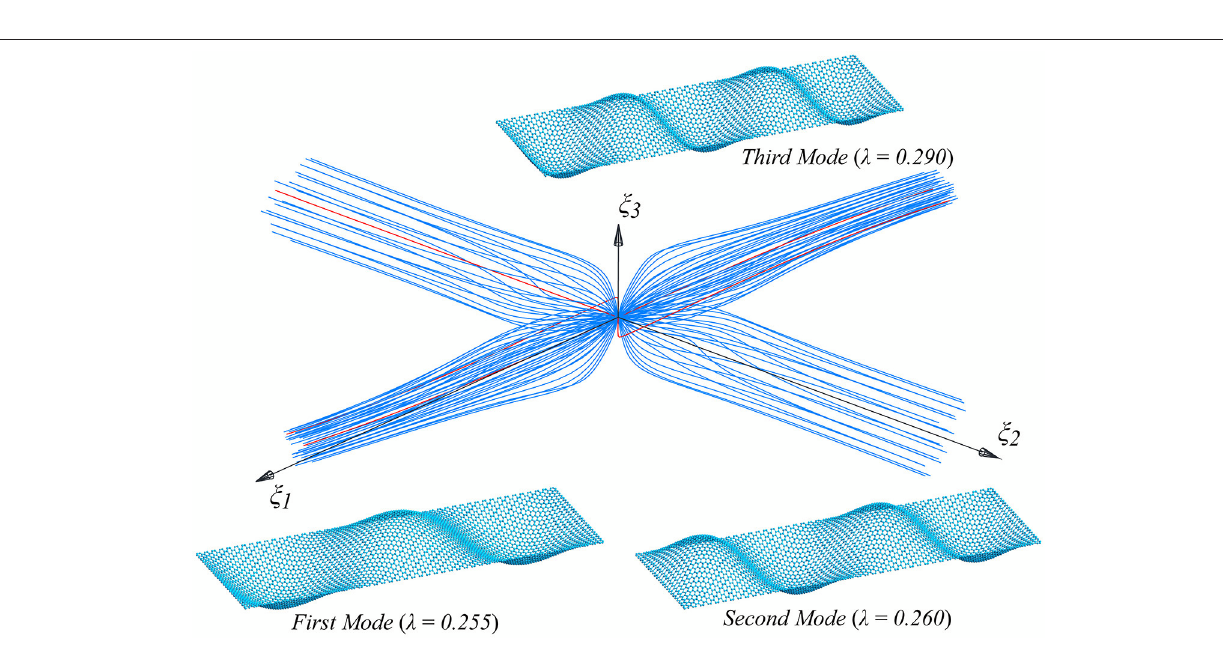
The equilibrium path, after an initial stable post-critical behavior (point A ), presents a limit load (point B ). The critical multiplier estimated numerically λ cr agrees well with